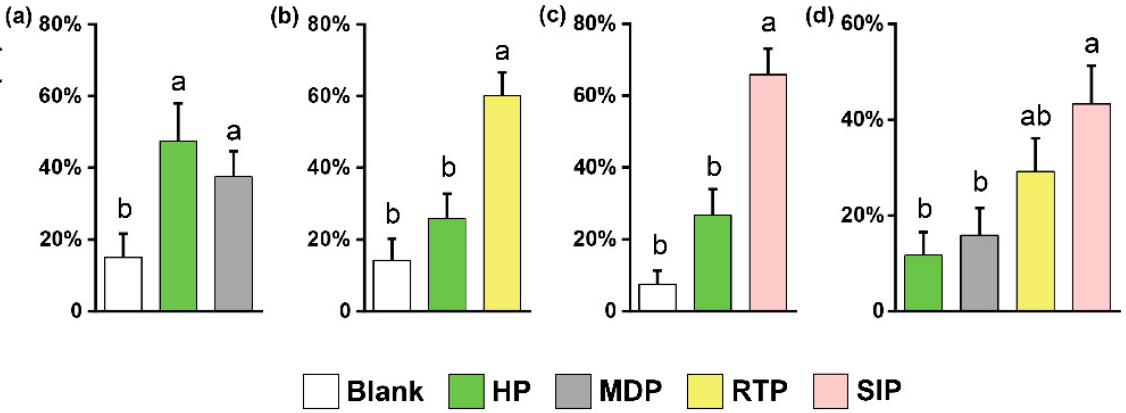
Figure 1. Percentage of M. similis females attracted to treatments in a four-arm olfactometer. Prefer- ence of M. similis for ( a ) Mechanically damaged vs. healthy plants and blanks (M. similis olfactometer experiment (1); ( b ) RTP-treated plants vs. healthy plants and blanks ( M. similis olfactometer experi- ment (2); ( c ) Plants infested with S. litura for 12 h vs. healthy plants and blanks ( M. similis olfactometer experiment (3), and ( d ) Mechanically damaged, RTP-treated, S. litura -infested, and healthy plants ( M. similis olfactometer experiment (4). Blank: empty odor source (no plants); HP: healthy plants; MDP: mechanically damaged plants; RTP: “regurgitate”-treated plants; SIP: S. litura -infested plants. Values are means + SE. Bars labeled with different letters are significantly different by Tukey’s HSD test ( p < 0.05; one-way ANOVA, α = 0.05).